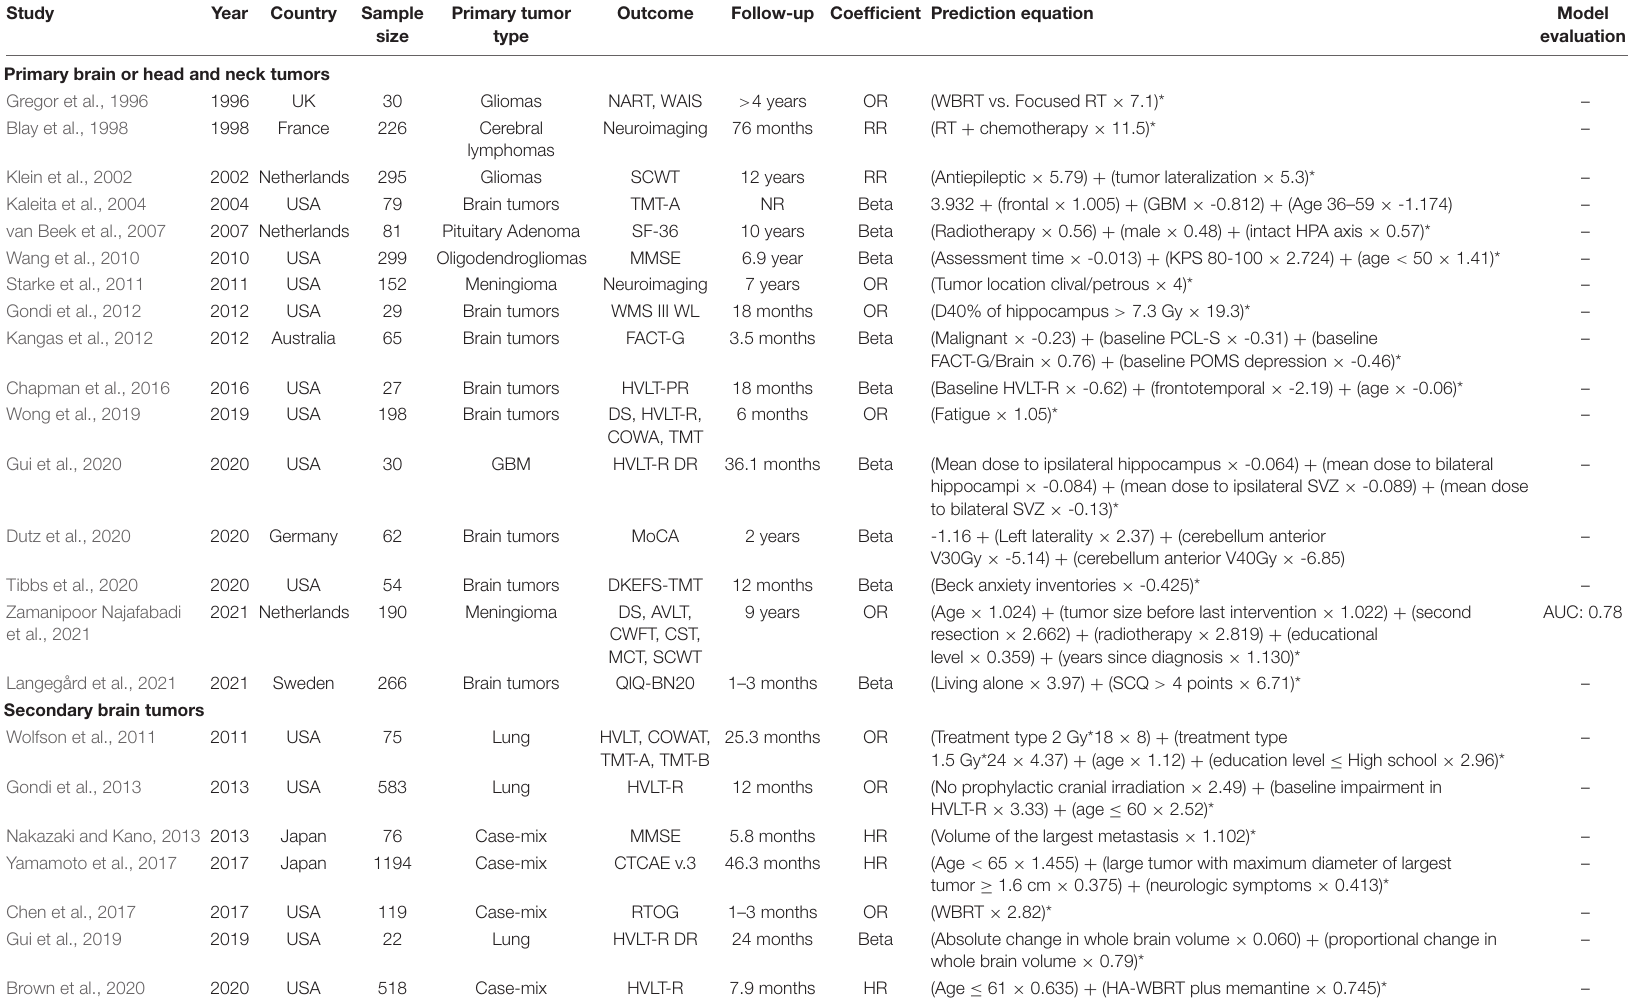
TABLE 1 | Characteristics of the prediction model studies for radiation-induced neurocognitive decline in patients with primary or secondary brain